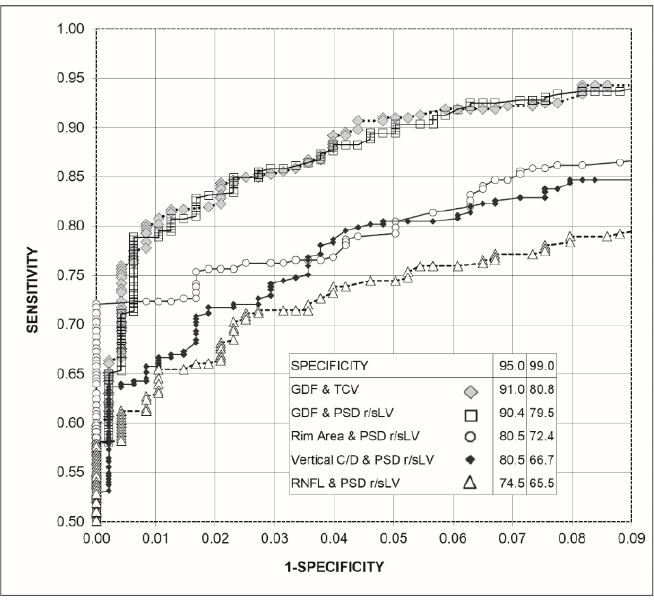
Figure 3. Graph of the receiver operating characteristic curve (ROC) of the combinations of Laguna ONhE and Cirrus-OCT indices with the perimetrics, as well as percentage sensitivities for 95% and 99% specificities.